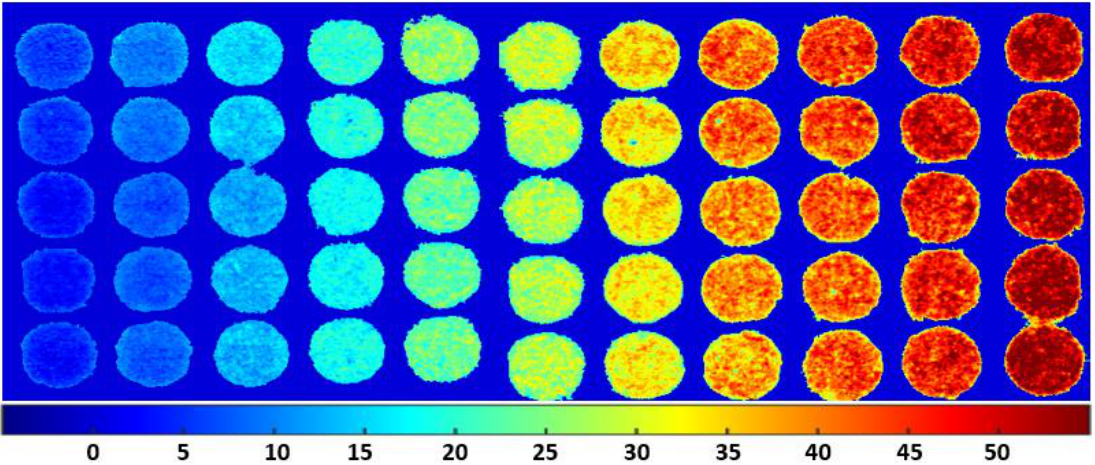
Figure 12. A chemical visualization map of almond is adulterated with apricot at different